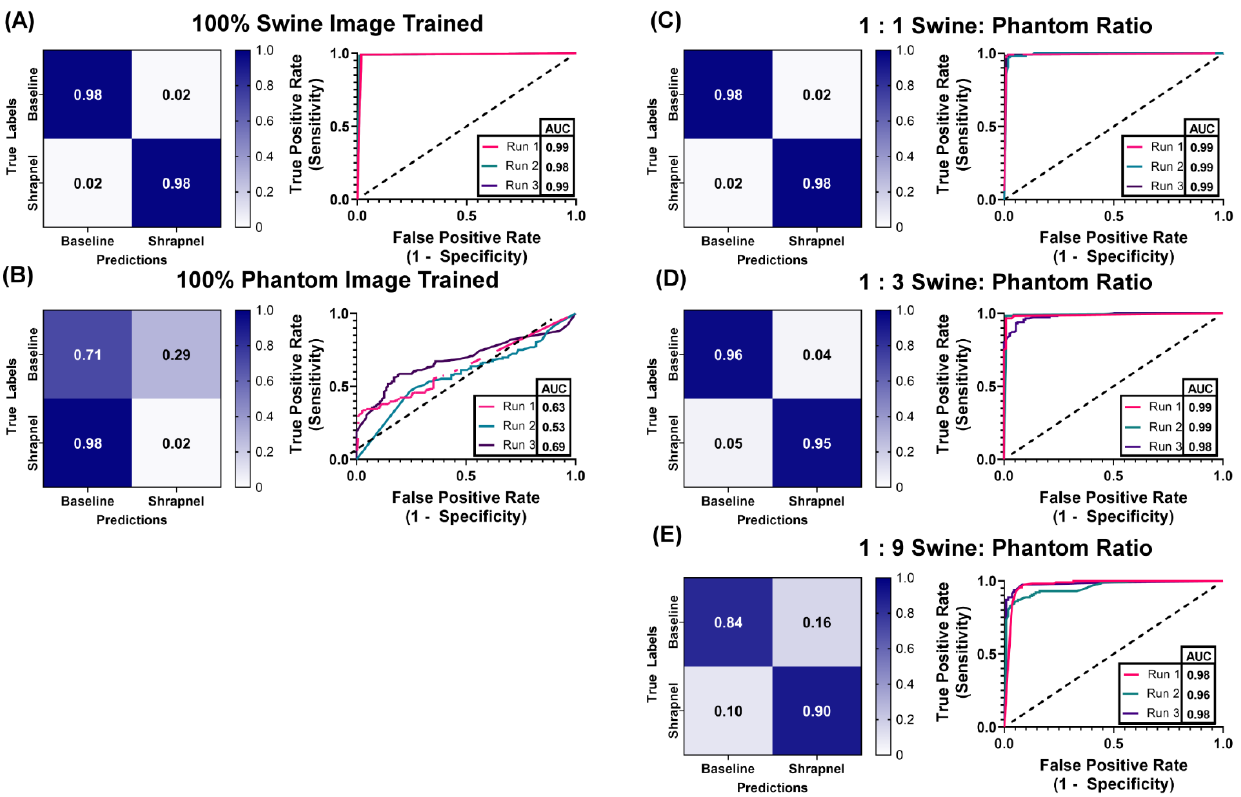
Figure 6 . Swine-Phantom Hybrid Training Results with ShrapML for Shrapnel Image Classification. Confusion matrices and ROC analyses for swine image prediction after training with image sets augmented with ( A ) 1:0, ( B ) 0:1, ( C ) 1:1, ( D ) 1:3, or ( E ) 1:9 swine: phantom ratios. The diagonal black dashed line in the ROC plots represents the result for random chance (AUC = 0.50) for reference. Table 3. Summary of ShrapML model performance metrics for each training situation. Results are shown as average for three random training: validation splits.